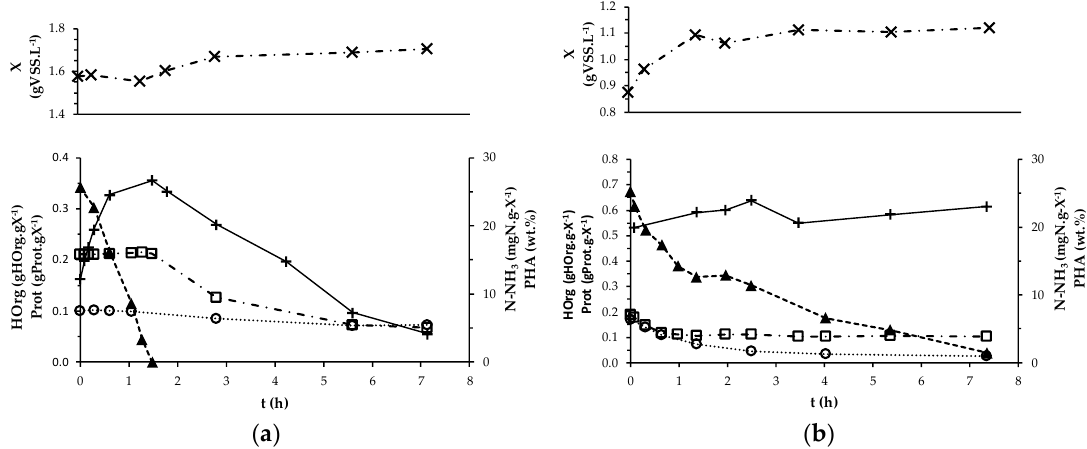
Figure 2. Typical profiles of biomass concentration ( X , × ), specific concentrations of organic acids ( H.Org , (cid:78) ), proteins ( Prot , ) and ammonia–nitrogen ( N-NH 3 , (cid:3) ), and biomass PHA content ( PHA , + ) obtained in SBR’s cycles in Period I ( a ) and Period IV ( b ).